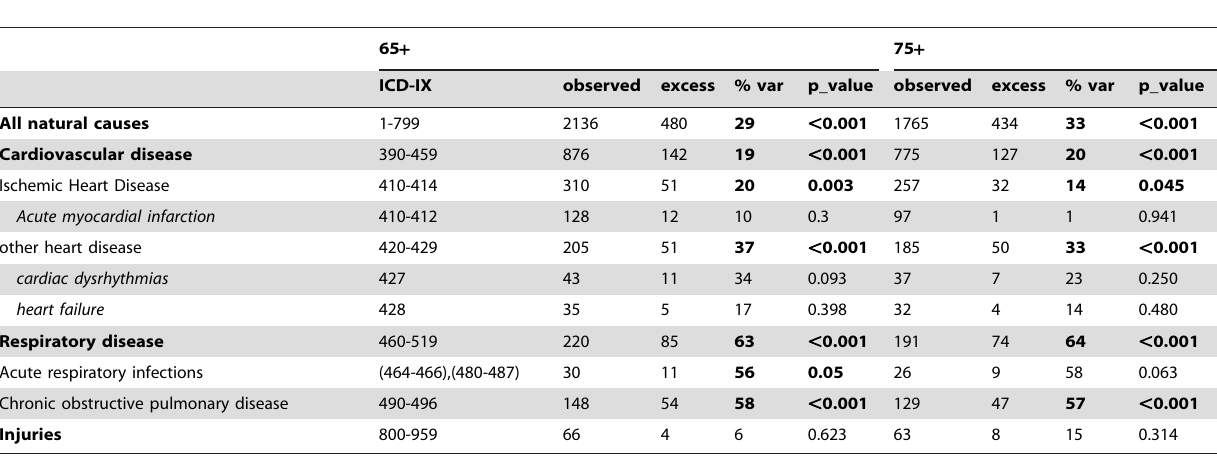
Table 3. Monthly observed, excess and percent variation in cause-specific mortality among the old (65 + years) and very old (75 + years) during February 2012 in